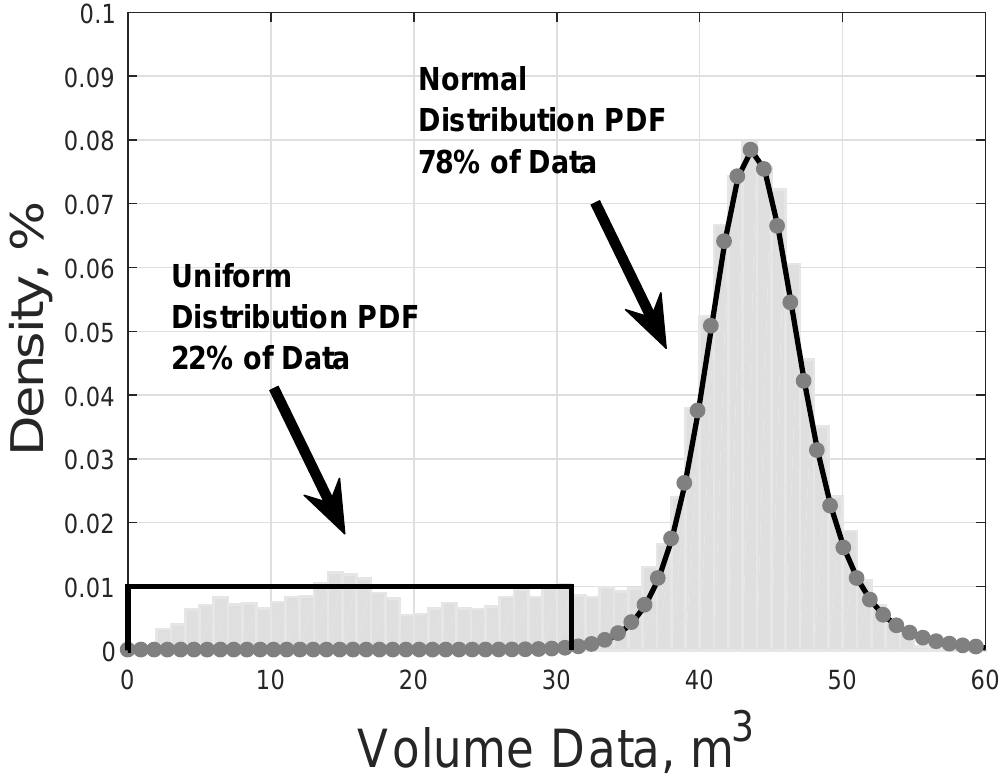
Figure 6. Histogram showing the amount of volume for